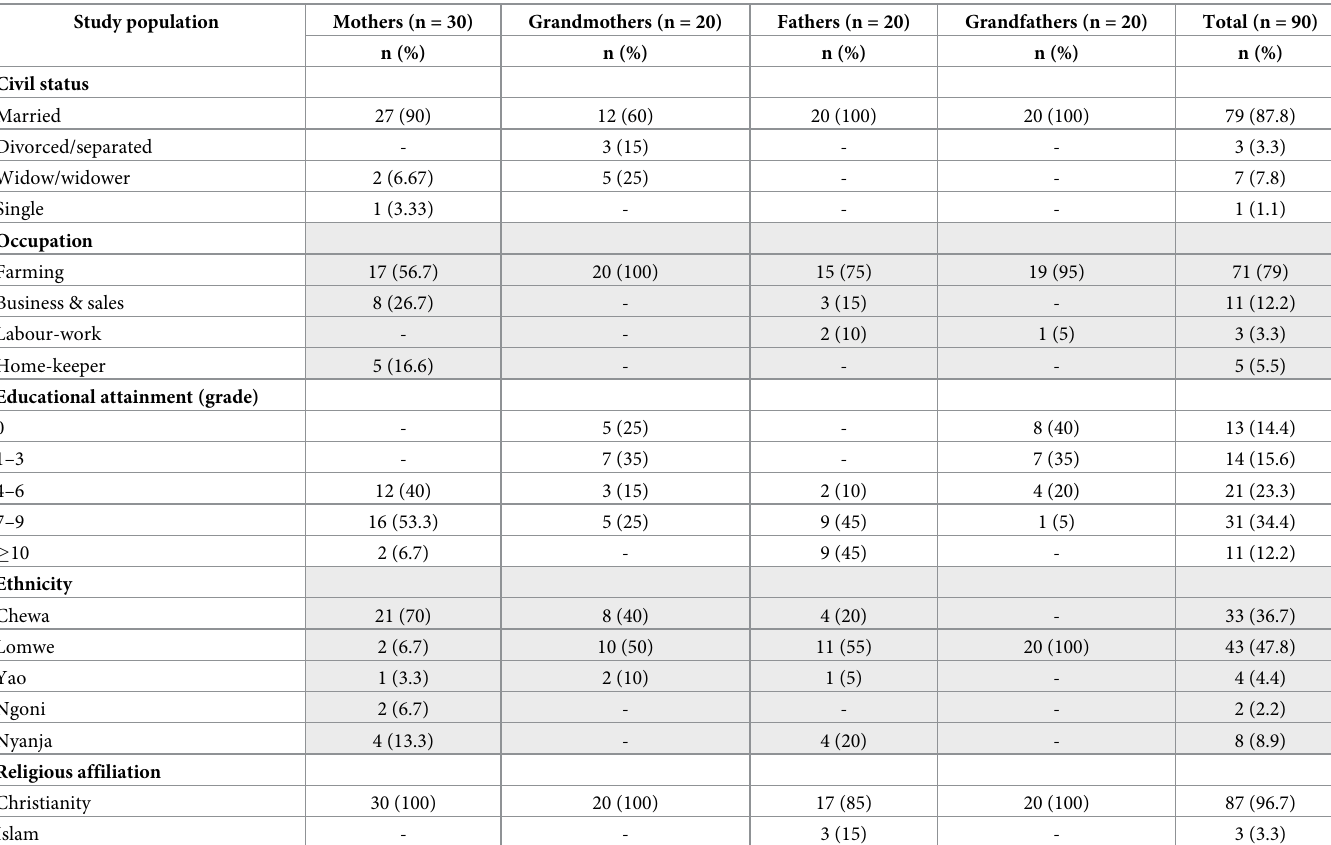
Table 2. Demographic characteristics of